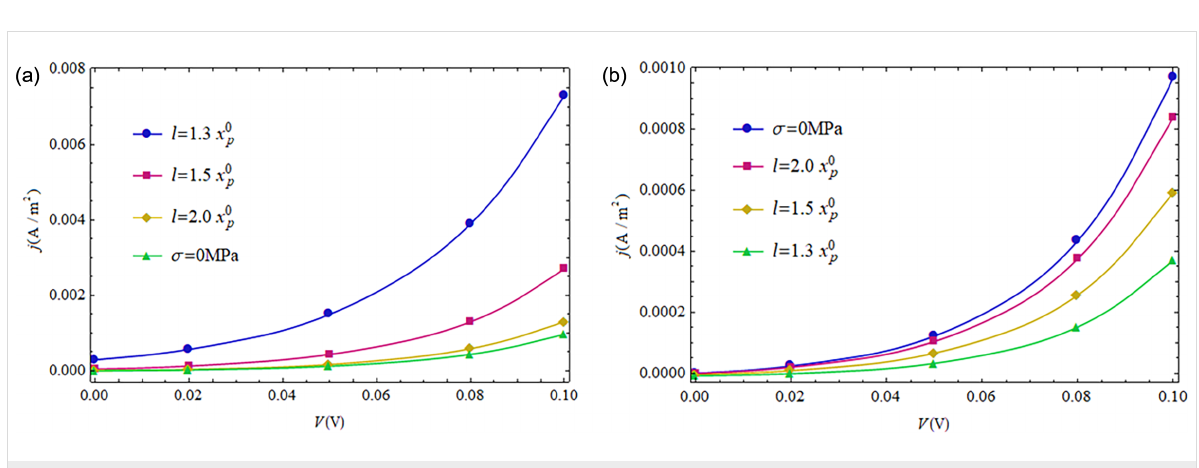
Figure 8: I – V characteristics for different loading locations under constant applied stress: (a) σ = − 10 MPa; (b) σ = 10 MPa.